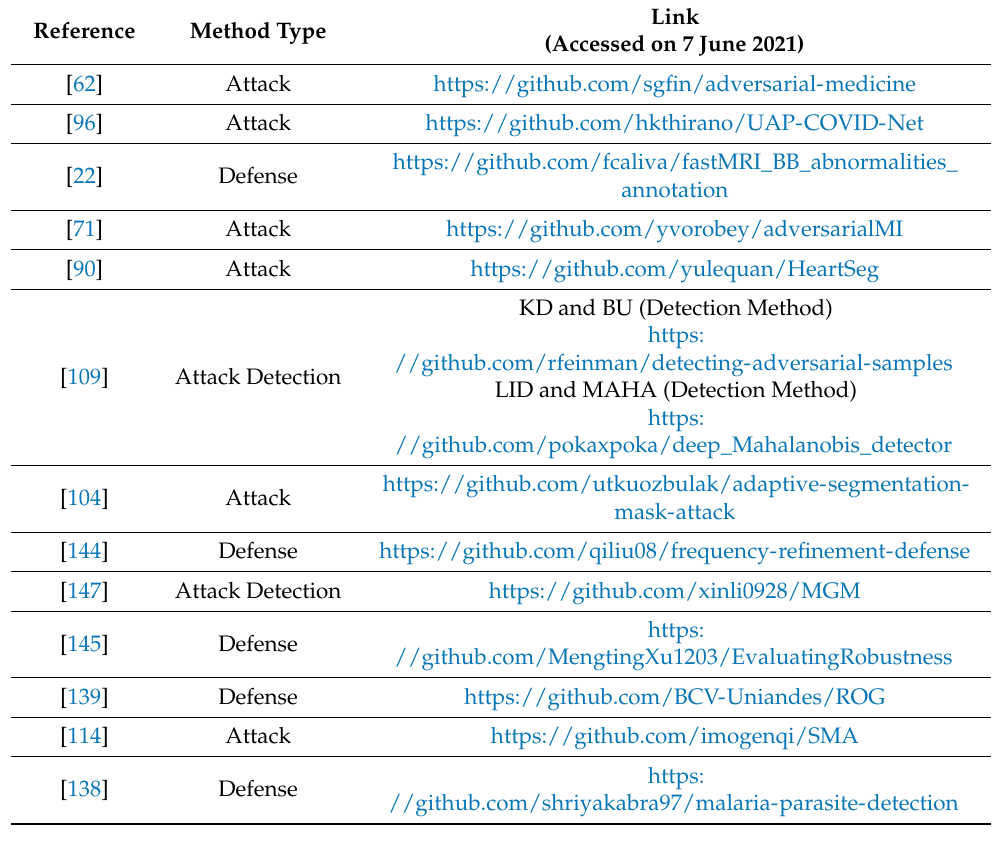
Table 5. Source codes in